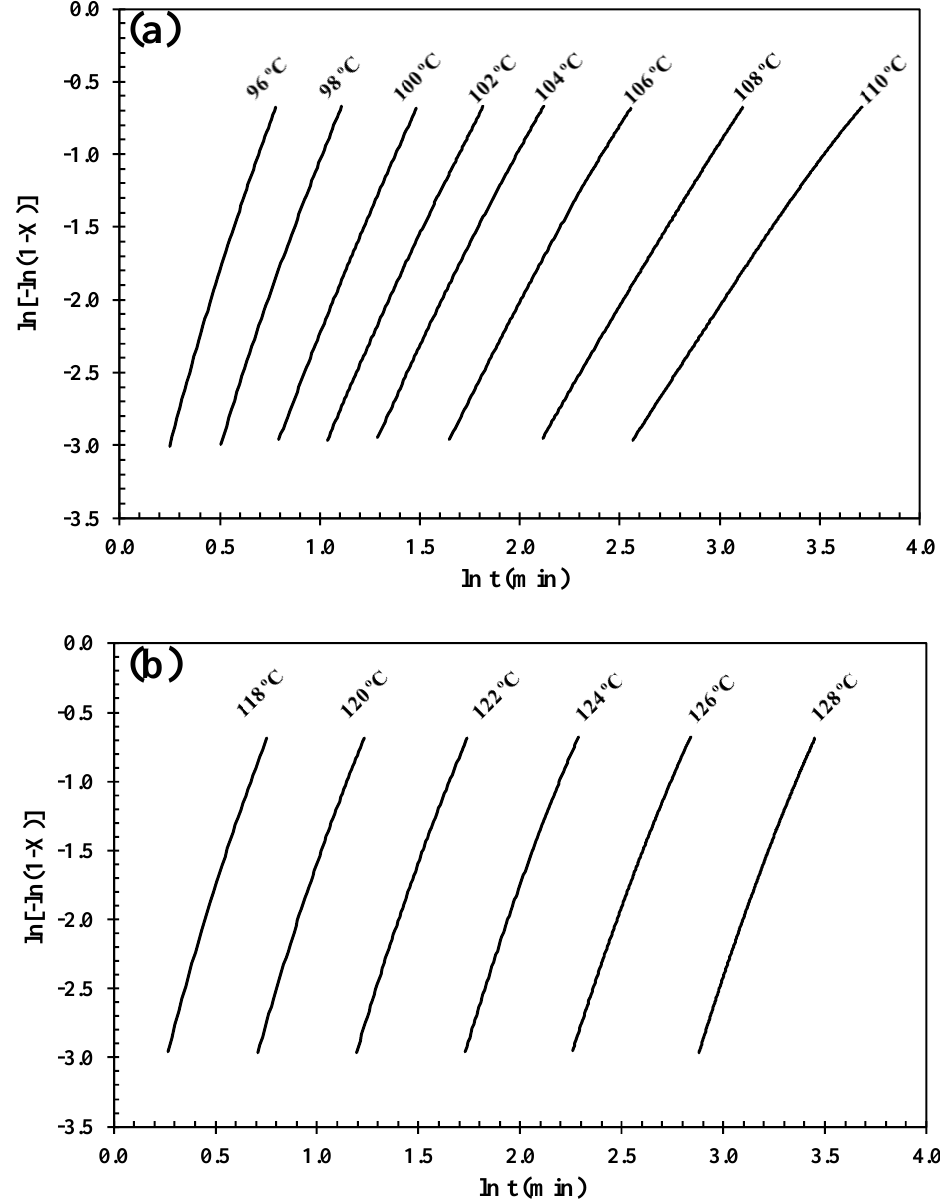
Figure 2. Avrami plots of the crystallization of ( a ) PHBV and ( b ) PHBV/INT-WS 2 (1.0 wt %) as a function of the crystallization temperature ( T c ).